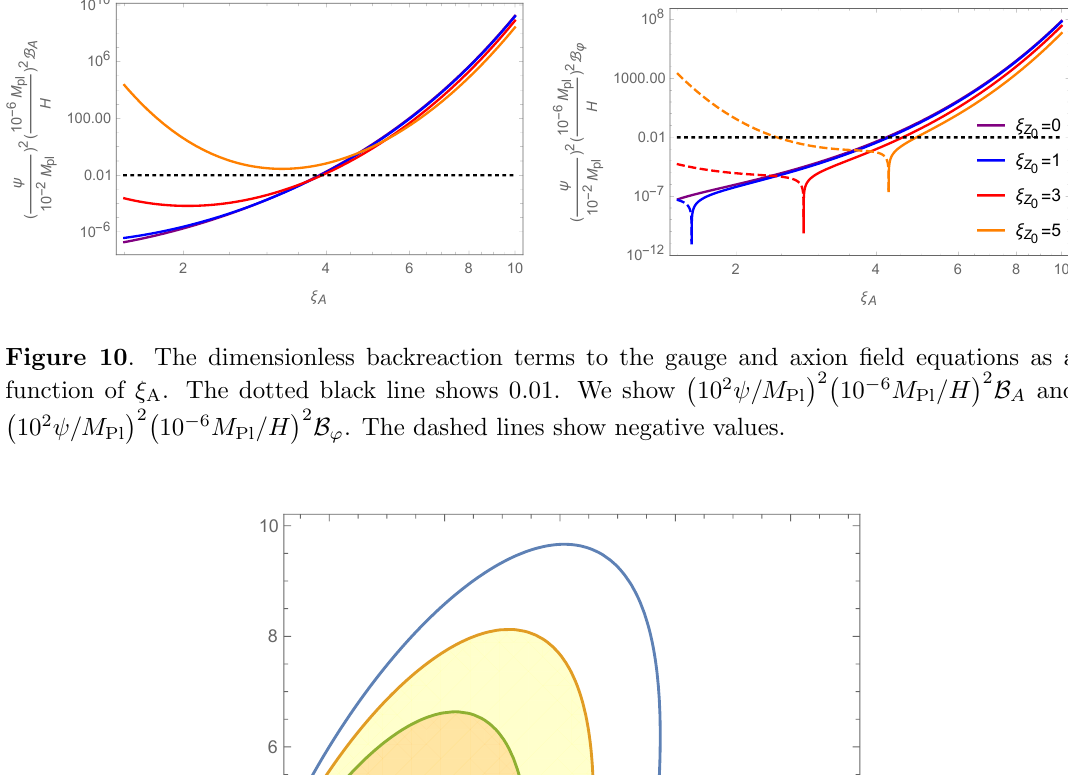
(cid:0) (cid:1) 2 (cid:0) (cid:1) 2 10 2 =M Pl 10 (cid:0) 6 M Pl =H B A and